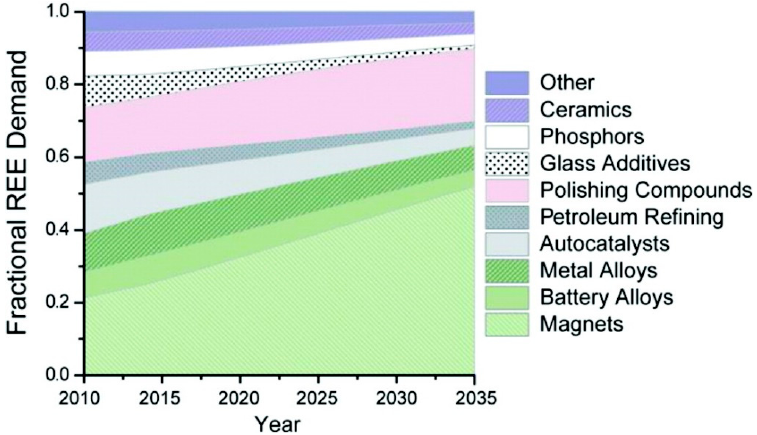
Figure 3. Predicted growths of market share of global rare earth elements (REEs) consumption [40]; published by American Chemical Society, 2012.